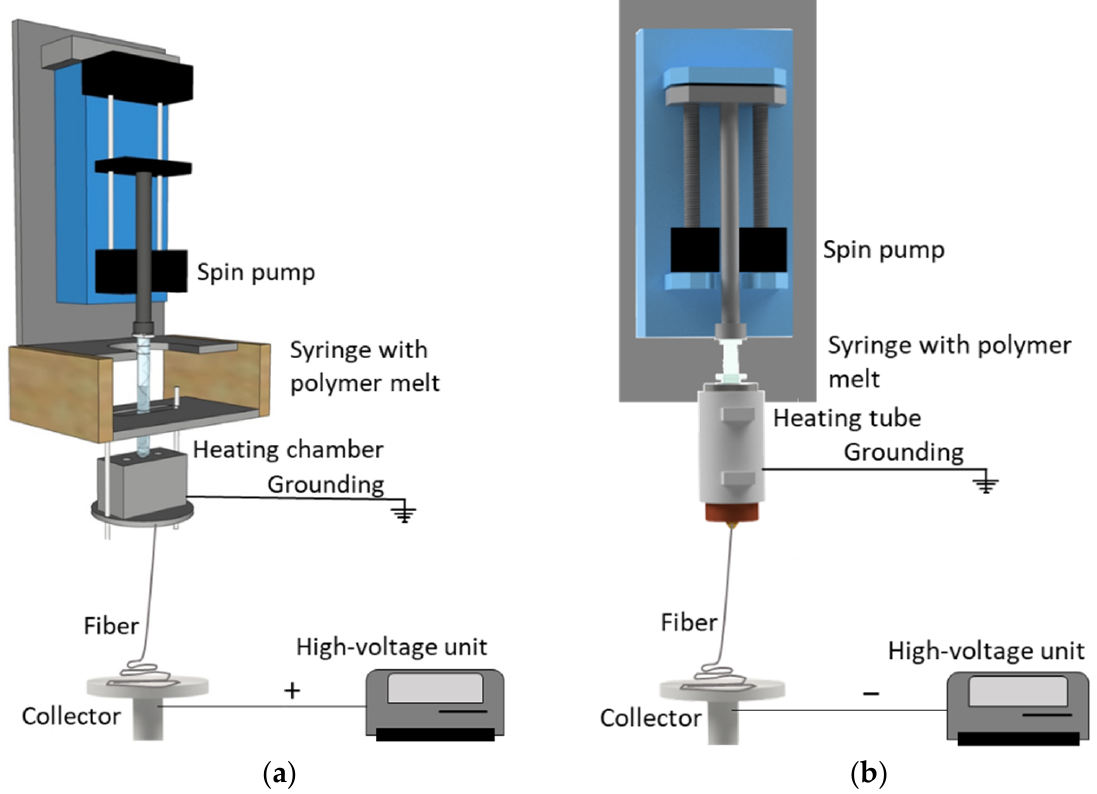
Figure 2 . Our single-nozzle laboratory-scale melt-electrospinning equipment. ( a ) Original setup before optimization, including a heating chamber consisting of several individual elements. ( b ) Modified setup including a continuous heating tube tailored to the syringe. Table 1. Process parameters for the laboratory-scale melt-electrospinning experiments. Trial